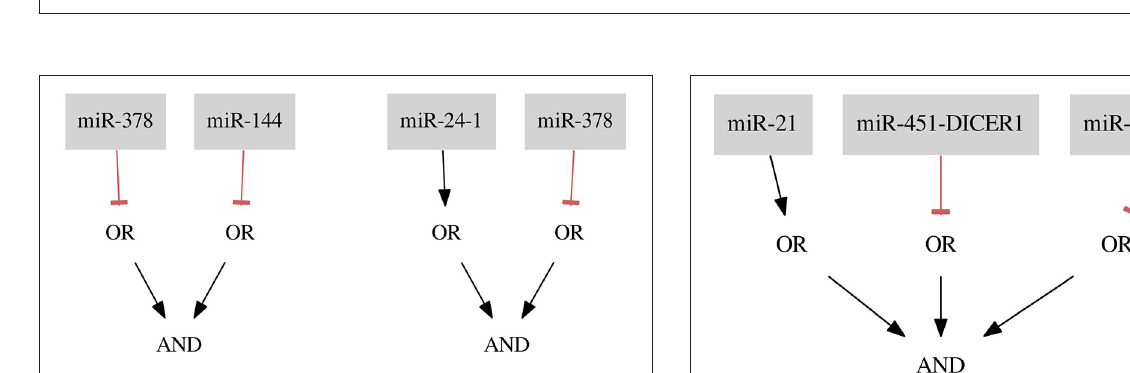
FIGURE 5 | Classifiers for Breast Cancer All data set.